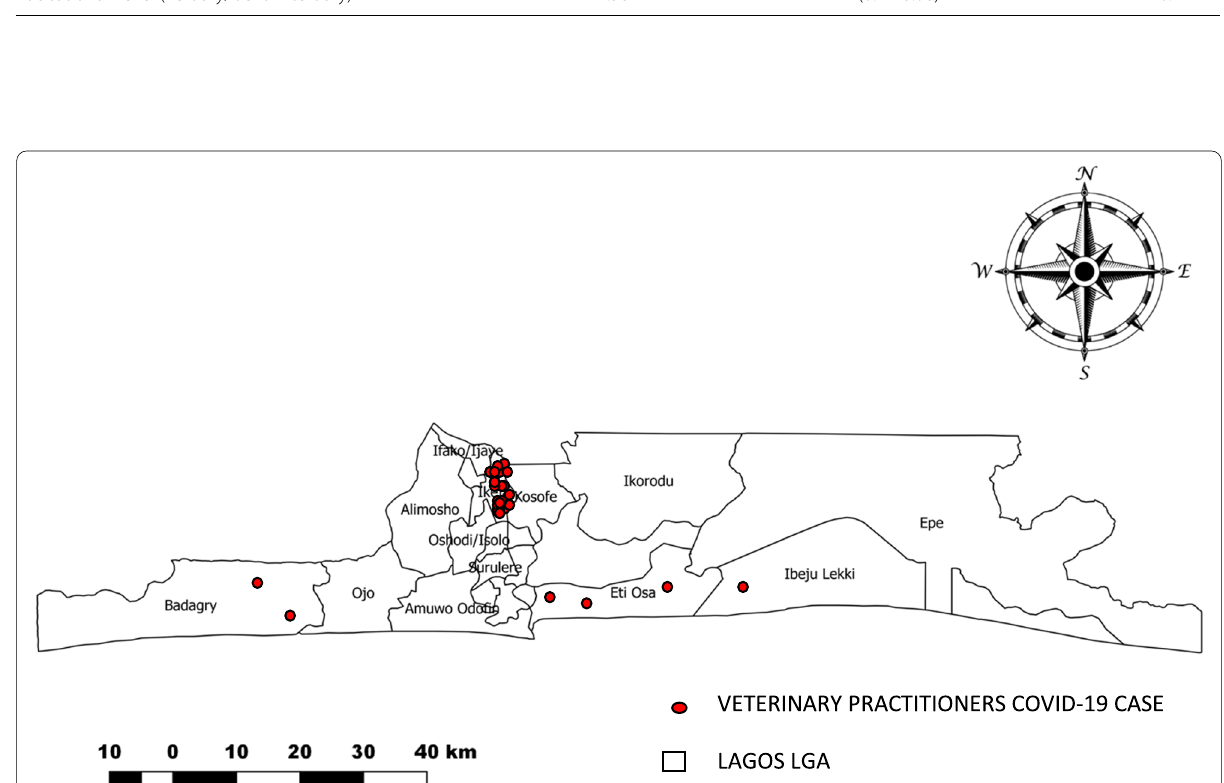
Fig. 2 COVID-19 cases among veterinary practitioners in Lagos by LGA of residency, June to August 2020. This showed the number and distribution of positive COVID-19 cases among veterinary practitioners in Lagos State, within the period of the study. A total of 25.9% of veterinary practitioners sampled returned a positive